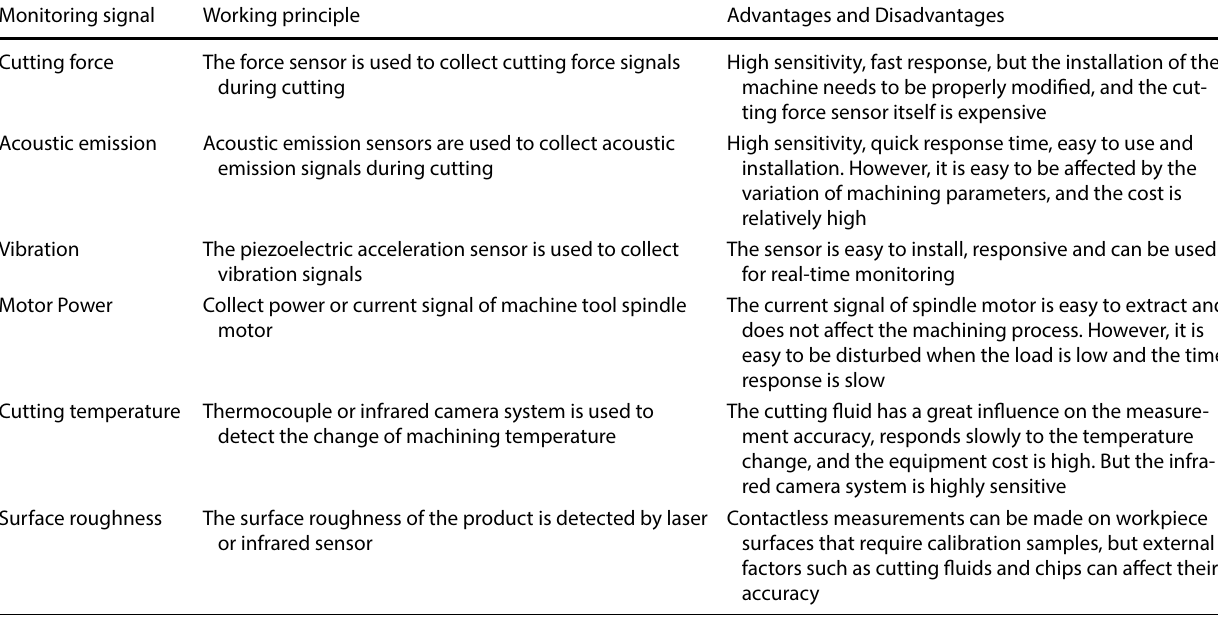
Table 1 Working principles and advantages and disadvantages of various monitoring signals [56] Monitoring